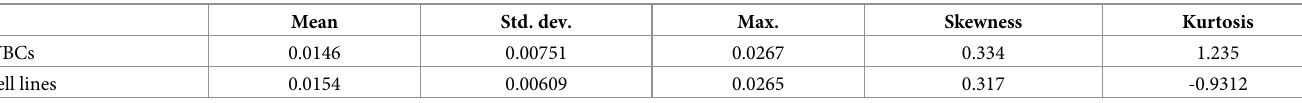
Table 2. Ensemble mean values of statistical parameters of OPL/D over all WBCs and